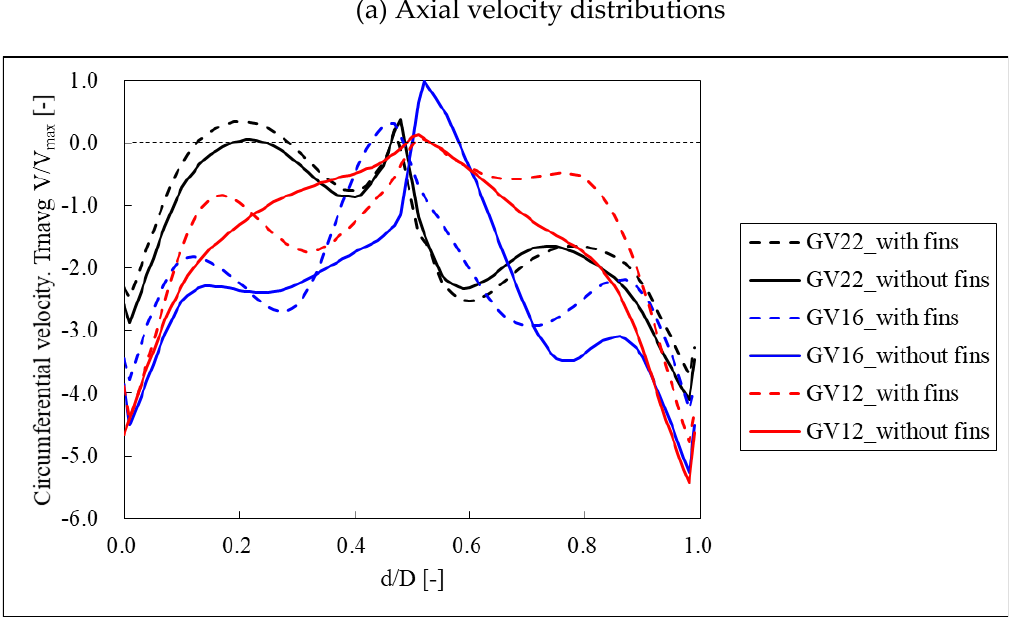
Figure 16. (a) Axial and (b) circumferential velocity distributions on the observed line in the DT. Figure 16. ( a ) Axial and ( b ) circumferential velocity distributions on the observed line in the